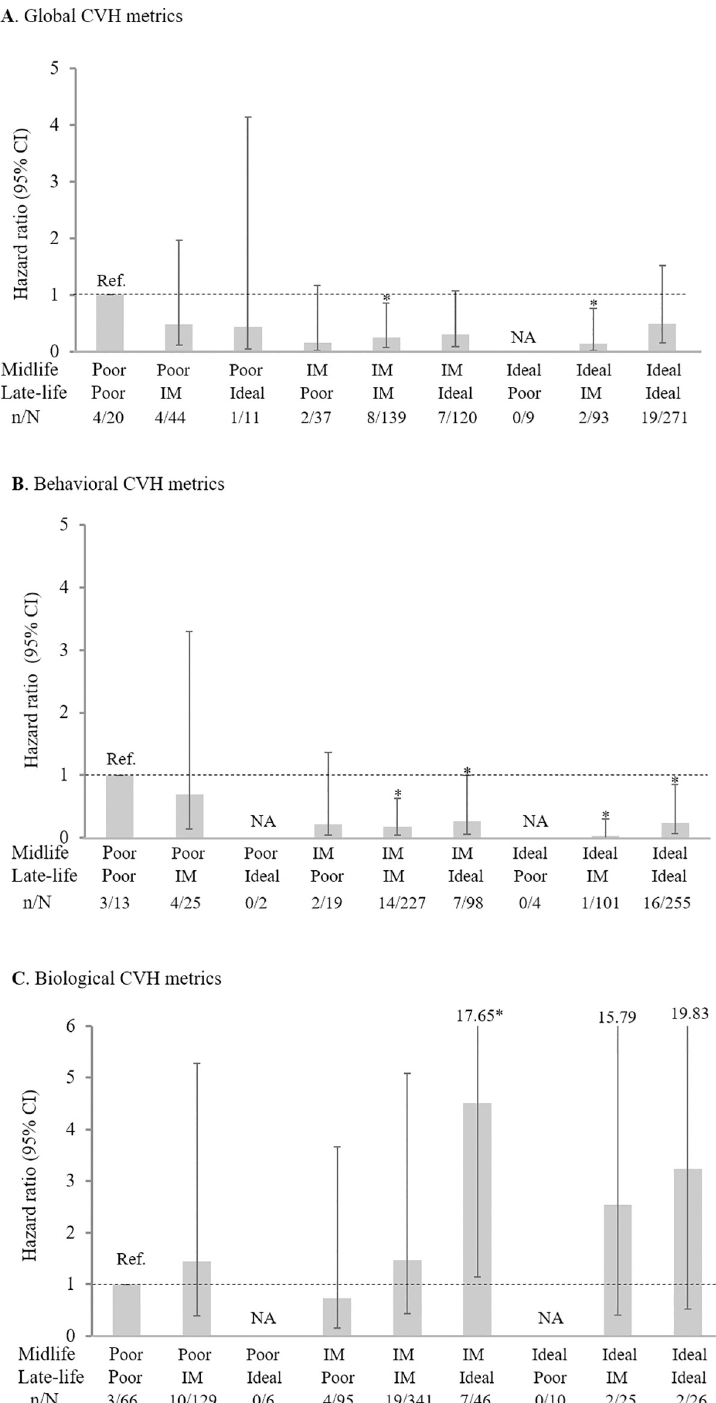
Fig 2. The HR (95% CI) of dementia associated with the joint patterns of midlife and late-life CVH metrics: A, global CVH metrics; B, behavioral CVH metrics; C, biological CVH metrics. HR (95% CI) was derived from the Cox proportional hazards models controlling for age, sex, education, APOE ε 4 allele, and cardiovascular disease in midlife. � p < 0.05. APOE, apolipoprotein E; CVH, cardiovascular health; CI, confidence interval; HR, hazard ratio; IM, intermediate; NA, not available; n/N, the number of dementia cases/number of participants.